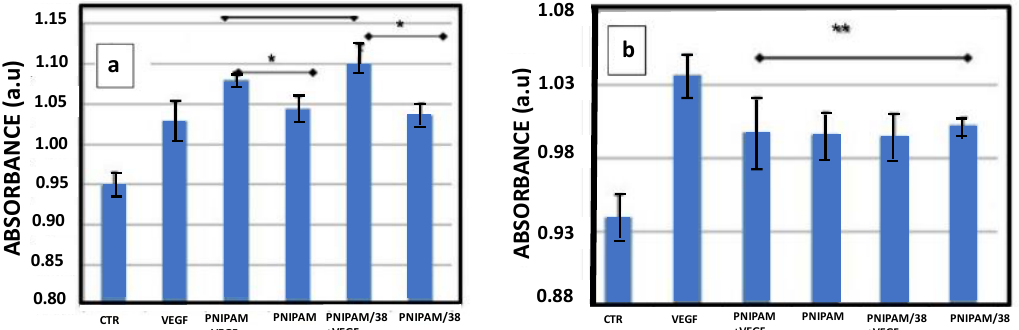
Figure 13. Absorbance measurements performed to address VEGF release for HUVEC cells incubated with PNIPAM (release temperature at 305 K) and PNIPAM/38 (release temperature at 311 K) loaded with VEGF and raised to different temperatures, ( a ) 311 K and ( b ) 293 K. The wells with standard cultural medium with and without VEGF (10 ng/mL) were used as controls. Experiments performed at 311 K show the ability of thermal release of VEGF loaded on PNIPAM based materials. (Images reprinted with permission from [95], Springer, 2014).